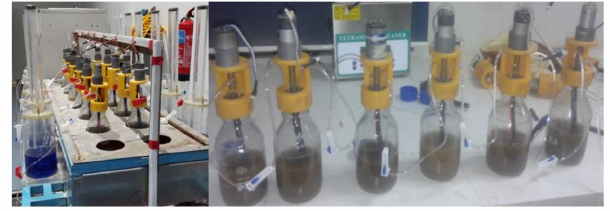
Figure 3. Lab scale batch mode anaerobic digester setup and